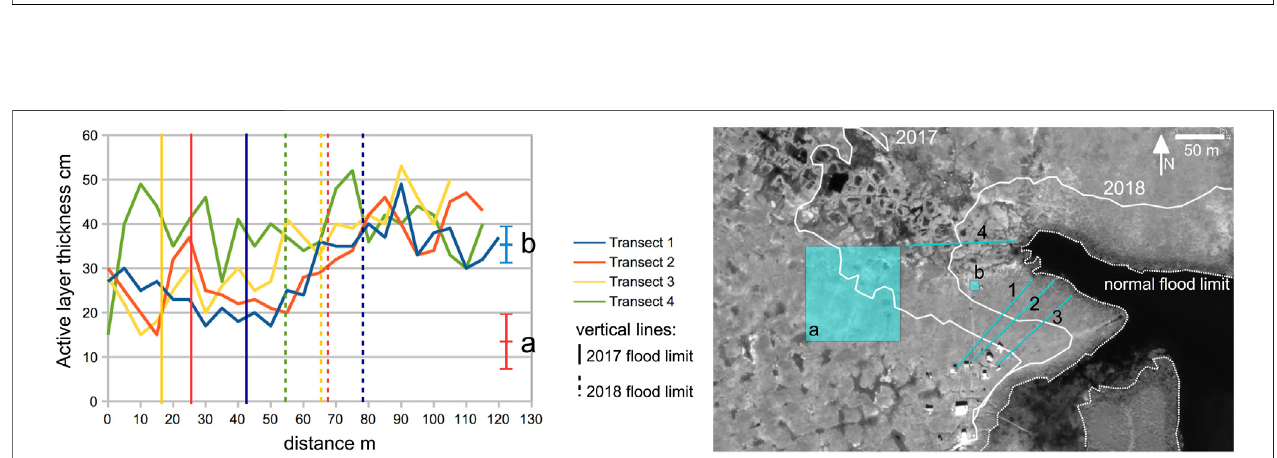
FIGURE9 | Active layer thickness transects through the 2017 and 2018 fl ood limits. Left: ALT thicknesses plotted against distancesfrom thestart of thetransects (from ± easttowest).Right:locationofthetransects(1 – 4).TheaverageandstandarddeviationofALToftwogriddedplots,onelargelyoutsidethe fl oodlimits(left,a)and one within the 2018 and 2017 limits (left, b), is indicated to the right of the transects in the graph on the left side. Scale bar 50 m. WorldView © 2019 MAXAR.